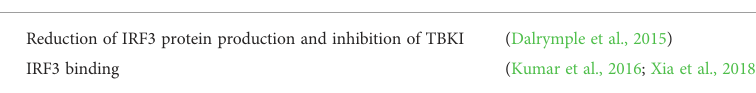
TABLE 1 Host innate immunity against DENV and ZIKV.